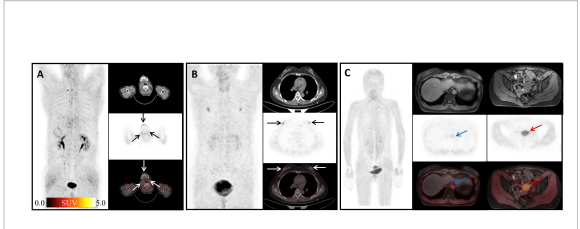
FIGURE 5 Physiological uptake of 68 Ga-FAPI-04. (A) A 72-year-old man with duodenal papillary tumor; arrows show atherosclerosis of the abdominal aorta with SUV max =4.65. (B) A 70-year-old woman presented with adenocarcinoma at the descending colon – sigmoid junction; arrows show left shoulder arthritis with SUV max =11.09. (C) A 55-year-old woman with signet ring cell carcinoma of stomach 2 months after ESD; arrows show left sternoclavicular arthritis with SUV max = 8.21.